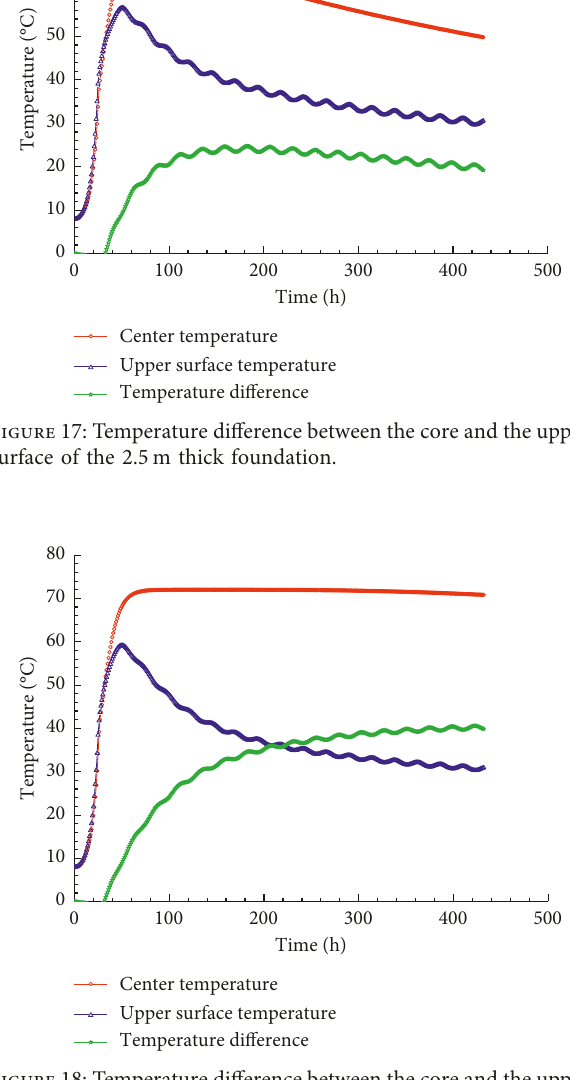
Figure 19: Wind turbines and foundation after the completion of construction: (a) two of the constructed wind turbines and (b) a constructed foundation.